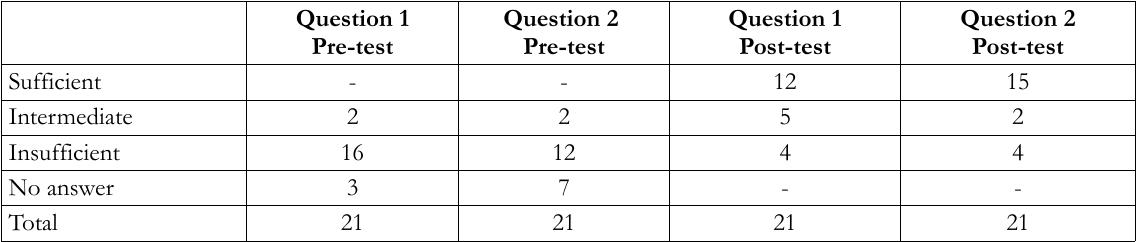
Table 3. The sufficiency of mental representations in responses to questions 1 & 2